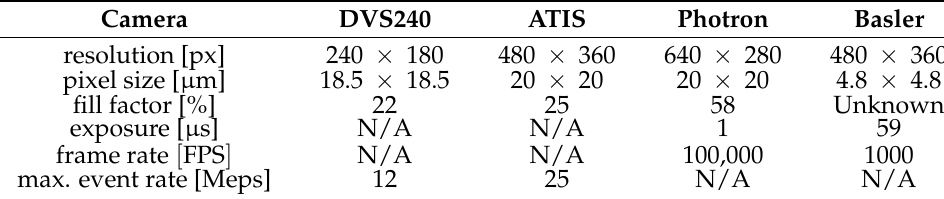
Figure 3. The ballistic shooting range setup. Table 1. Camera parameters. Meps—million events per second, FPS—frames per